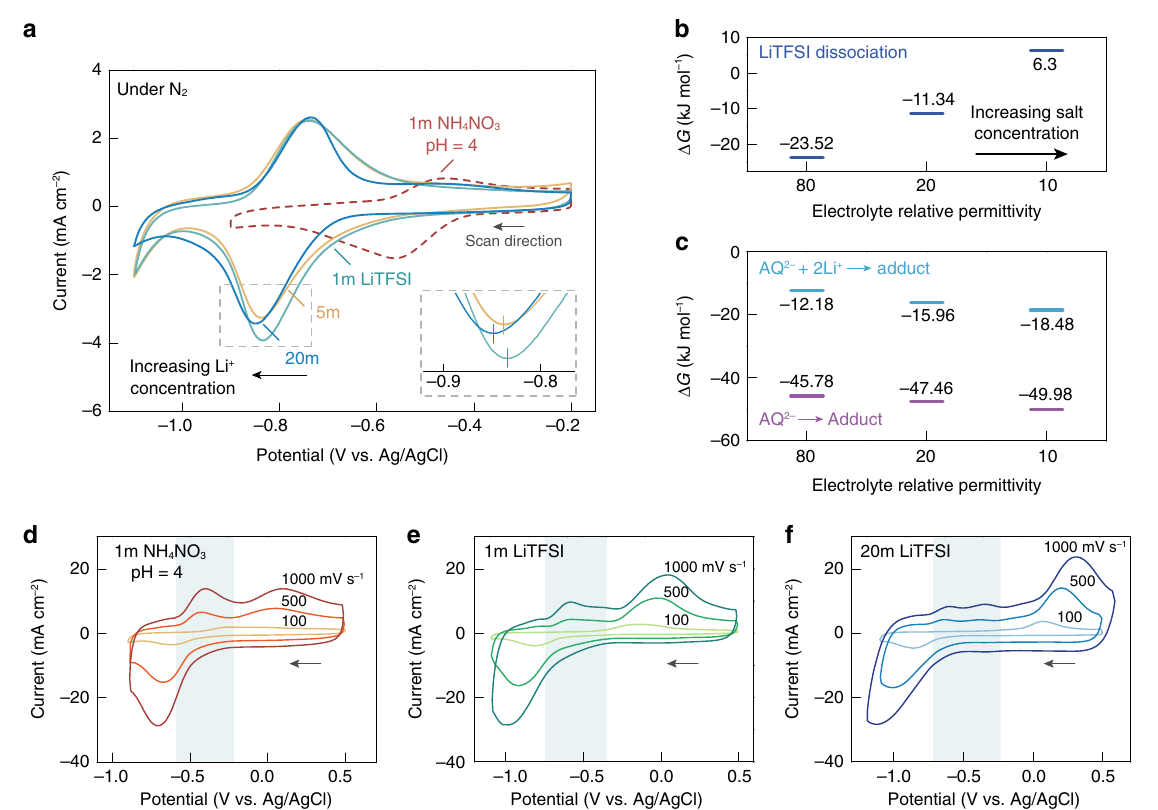
Fig. 3 Enhanced reactivity of CO 2 with quinones in salt-concentrated media. a CV of PAQ-CNT in 1m NH 4 NO 3 , 1, 5 and 20m LiTFSI under N 2 . The scans were conducted at a rate 50 mV s − 1 . b The free energy change for LiTFSI dissociation at different electrolyte permittivities. Relative permittivities of 80 and 10 correspond to 1 and 20m LiTFSI, respectively. The process becomes nonspontaneous at high LiTFSI concentrations. c The free energy change for quinone-CO 2 adduct formation at different electrolyte permittivities, starting from both AQ 2 – and AQ 2 – complexed with Li + . The adduct formation becomes thermodynamically more favorable at higher LiTFSI concentrations. d − f CV of PAQ-CNT at different scan rates in 1m NH 4 NO 3 ( d ), 1m LiTFSI ( e ), and 20m LiTFSI ( f ) under CO 2 . The shaded area corresponds to the oxidation of quinone dianions that are unreacted with CO 2 . For all the CV measurements, PAQ was cast on glassy carbon at a loading of 0.042 mg cm − 2 , Pt wire was used as the counter electrode, and Ag/AgCl was used as the reference electrode. Source data are provided as a Source Data fi